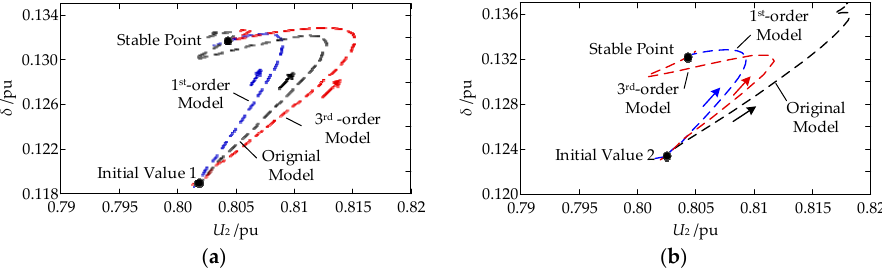
Figure 4. Simulation results of original and reduced systems under different initial values for test system 1: ( a ) at Initial Value 1; ( b ) at Initial Value 2. system 1: ( a ) at Initial Value 1; ( b ) at Initial Value